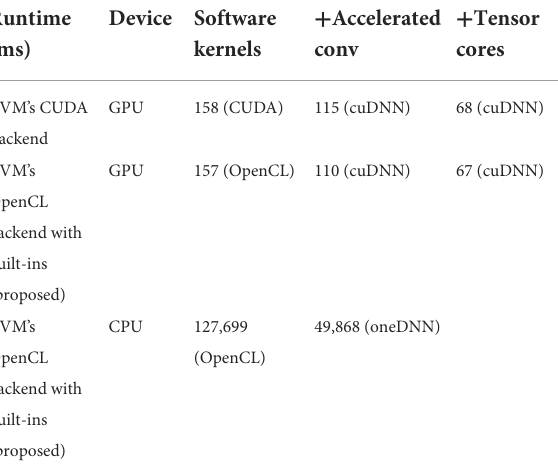
TABLE 2 Inference runtime in milliseconds for the fastseg semantic segmentation network with NVIDIA RTX 2080 Ti GPU with 1,920 × 1,080 RGB